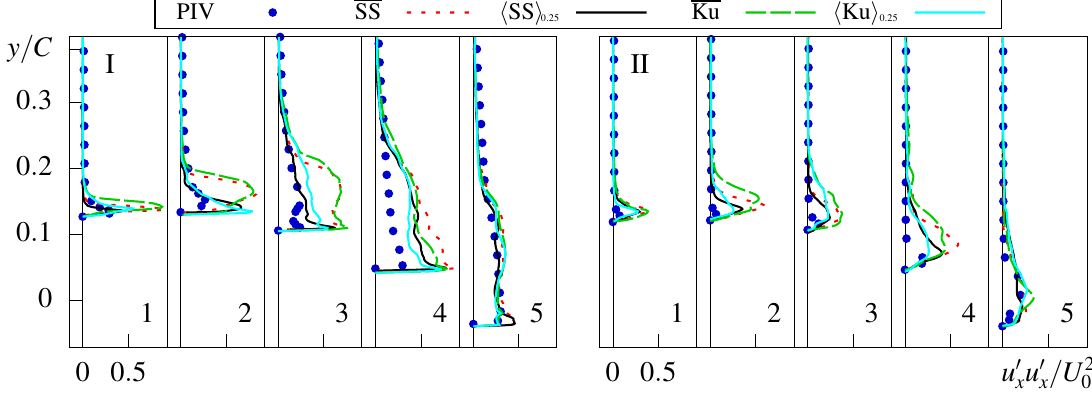
Figure 11. Similar to Figure 10 for streamwise velocity fluctuations. As for the conditional averaged shear stress obtained by the Schnerr–Sauer and Kunz models, their profiles are presented in Figure 12 in comparison with the PIV data. For the cross-sections 2 and 3 the conditional averaging reduces the time-averaged value of the shear stress. In positions 4 and 5, the numerical and experimental results are close to each other. The values of the shear stresses for regime II are a bit overestimated but, closer to the trailing edge, they are in good agreement with the PIV measurements. The overall results of the PIV and LES comparison are excellent for most flow regions due to the use of the conditional